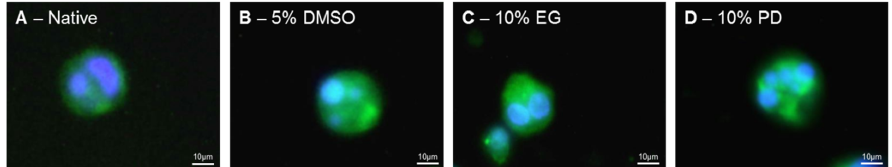
( D )—10% PD) cryopreservation. Representative fluorescence microscopy image of MKs stained with anti CD61-FITC antibody (green), nuclei stained with DAPI (blue). Int. J. Mol. Sci. 2020 , 21 , x FOR PEER REVIEW